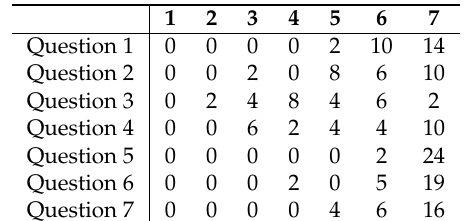
Table 6. Number of answers obtained for each value of the Likert scale.